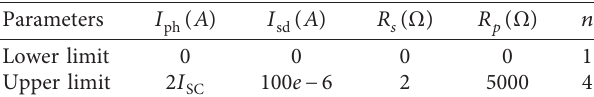
Table 9: Ranges of parameters for ST40 and